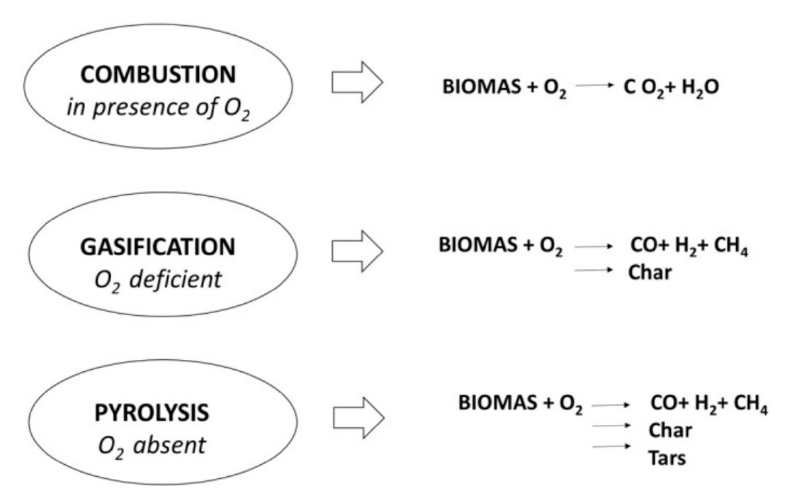
Figure 1. Scheme of combustion, gasification and